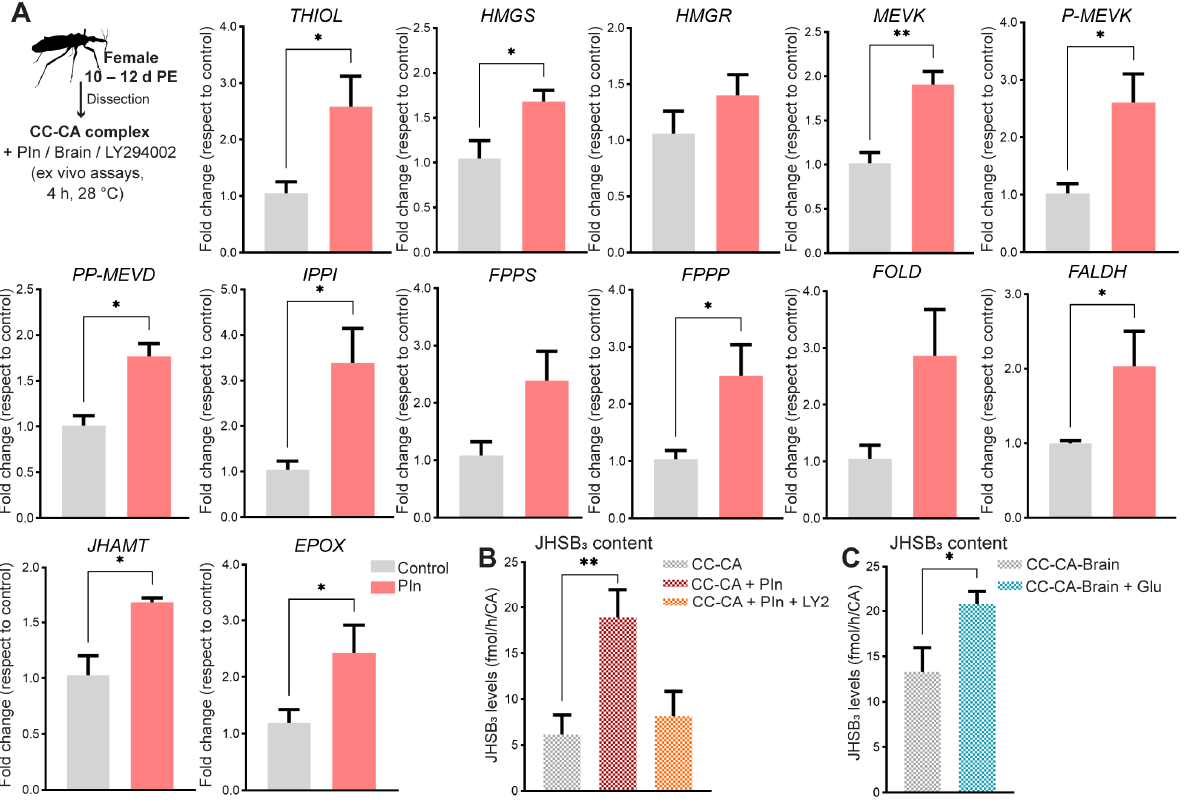
Figure 4. Role of insulin in JHSB 3 production in ex vivo assays. ( A ) CA-CC complexes from unfed females (10–12 d post-ecdysis) were incubated ex vivo at 28 °C in the dark, in culture medium supplemented with porcine insulin (3 µM), or the same volume of saline (control). Four hours later, transcript expression of the JH biosynthetic enzymes in the CC-CA complex were quantified using RT-qPCR and analyzed by the 2 −ΔΔ Ct method. The y axes represent the fold change in expression relative to control (saline, gray column, value ~1) obtained via geometric averaging using Rp49 and actin as reference genes. The results are shown as the mean ± SEM of n = 5, where each n represents a pool of CC-CA complexes from 3 insects. * p < 0.05; ** p < 0.01; (Student’s t -test). ( B ) JHSB 3 levels in culture media from: group 1, the CC-CA complexes alone; group 2, CC-CA complexes incubated with porcine insulin (3 µM); and group 3, the CC-CA complexes pre-incubated for 1 h with LY294002 (Ly2, final concentration: 50 µM) prior to porcine insulin (3 µM) treatment. The y axes represent JHSB 3 titers (fmol) per h per CA. The results are shown as the mean ± SEM of n = 5–7, where each n represents the incubation medium that contained a pool of tissues from 3 insects. ** p < 0.01; (Student’s t -test). ( C ) JHSB 3 levels in culture media from: group 1, CC-CA complexes connected to the brain (CC-CA-Brain); group 2, CC-CA-Brain incubated with glucose (Glu, 50 mM). The y axes represent JHSB 3 titers (fmol) per h per CA. The results are shown as the mean ± SEM of n = 3–4, where each n represents the incubation medium that contained a pool of tissues from 3 insects. * p < 0.05; (Student’s t -test).